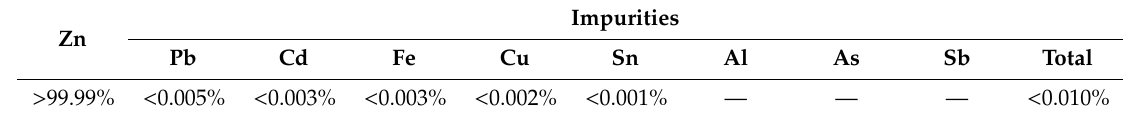
Table 2. Chemical composition of Zn99.99.